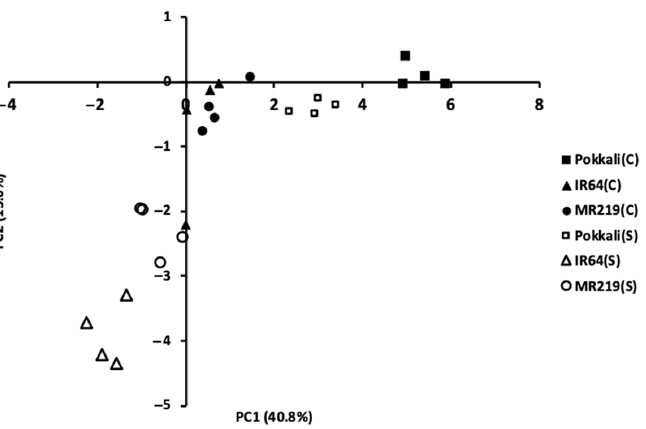
Figure 4. Scatter plot of the first two principal components with all variables, showing the distribu ‐ tion of the samples on day 10 of salinity treatment: (C) control/normal condition, (S) saline condition.